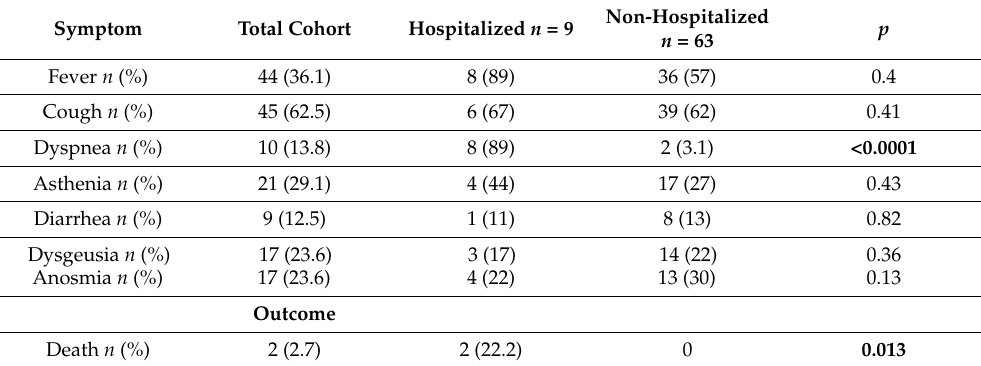
Table 2. COVID-19 most frequent symptoms in the total cohort; comparison of frequencies between hospitalized and non-hospitalized patients and